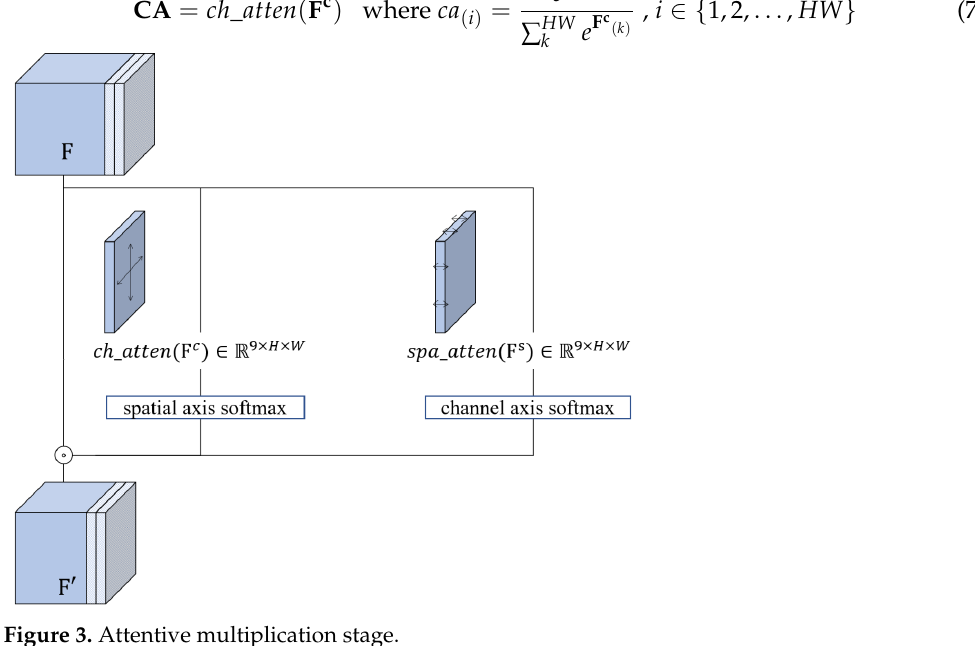
Figure 3. Attentive multiplication